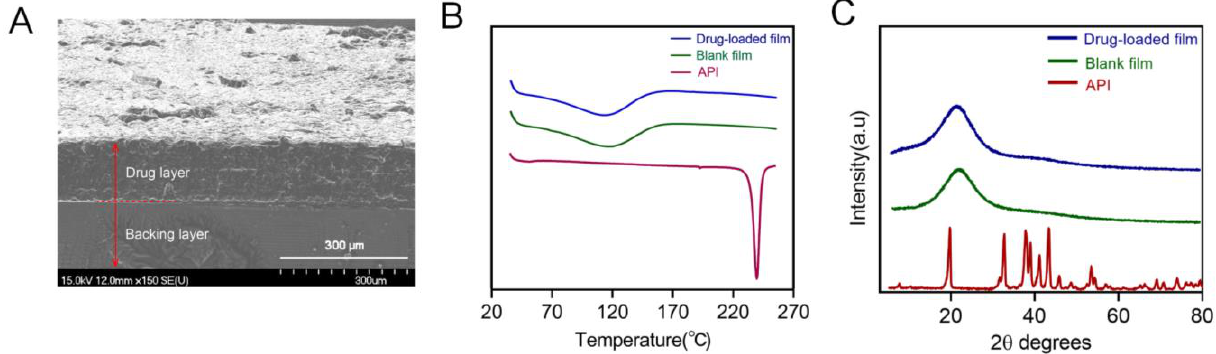
Figure 11. ( A ) Cross-sectional morphology of the printed bilayer film; ( B ) DSC analysis pattern spec-